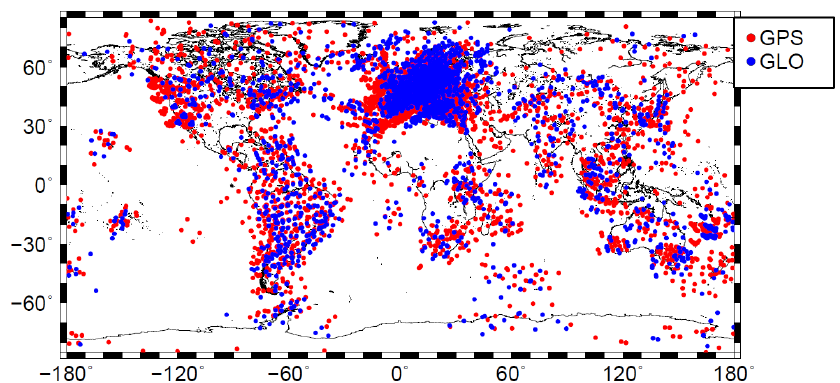
Figure 1. Distribution of IPPs collected from stations of the IGS and the EUREF network on 17 March 2015 at 12:00 UT. Blue colored dots indicate observations from GPS, red colored dots from